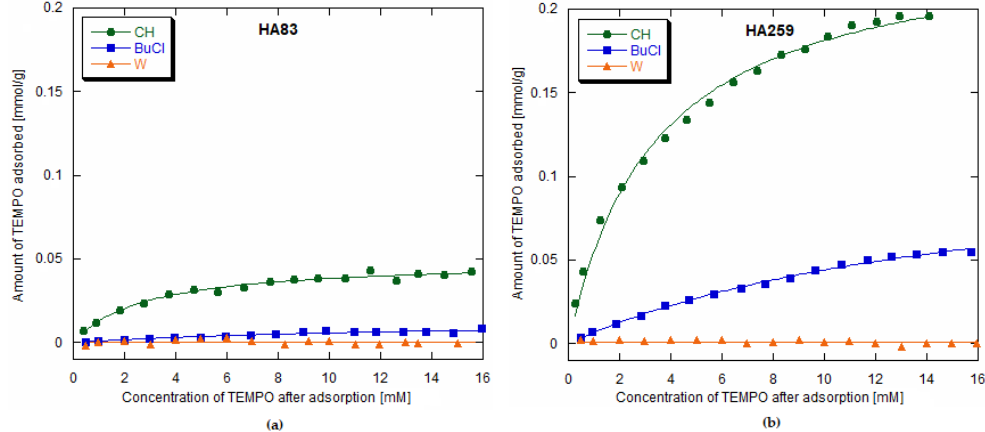
Figure 1. Adsorption isotherms of 2,2,6,6-tetramethylpiperidine-1-oxyl radical (TEMPO) on hydroxyapatites (HAs) from different solvents (Langmuir plots): ( a ) on HA83; ( b ) on HA259.